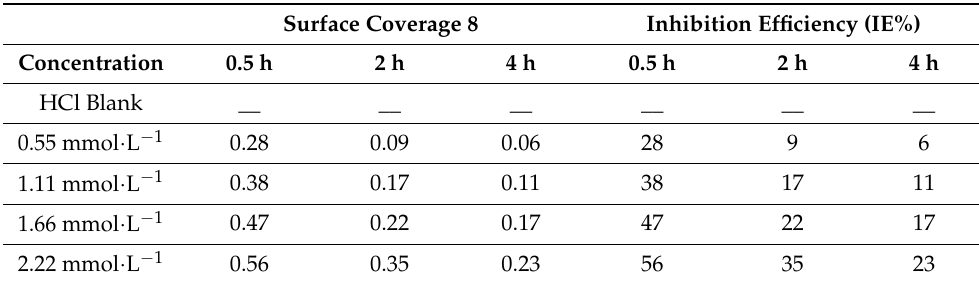
Table 1. The surface coverage and corrosion inhibition efficiency of different Q-22 inhibitor concen- trations for C-steel in 5 M HCl at 25 ◦